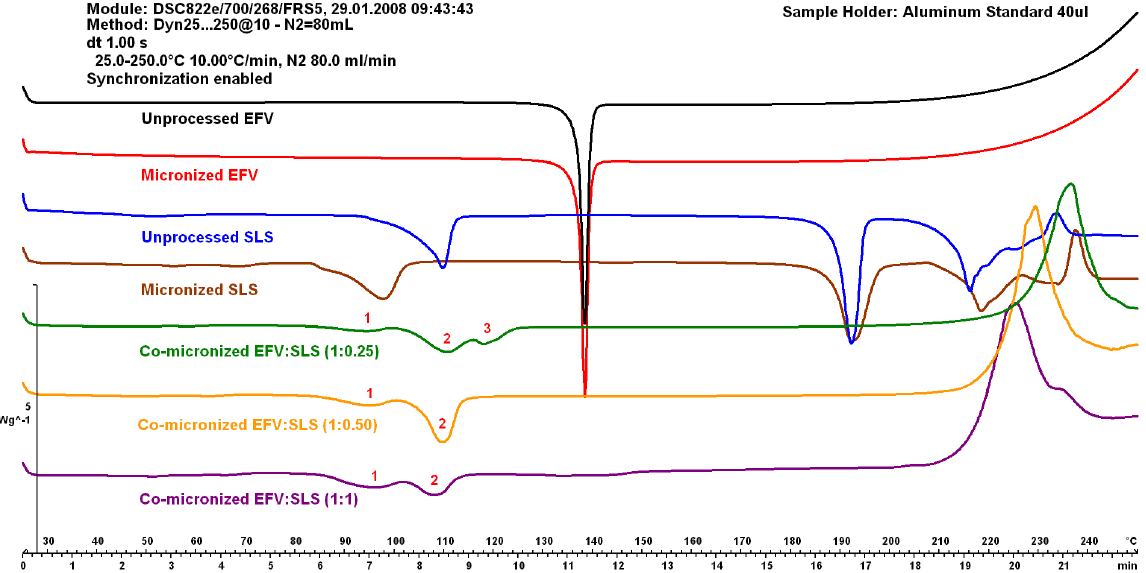
Figure 7. DSC curves of unprocessed and micronized efavirenz and SLS, compared to mixtures co-micronized at the proportions (1:0.25), (1:0.50) and